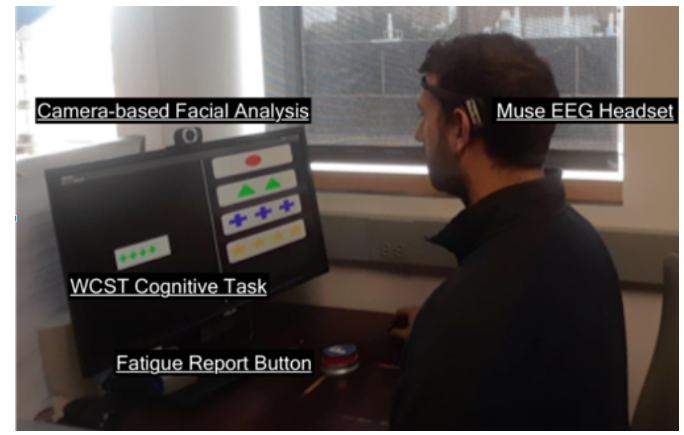
Figure 3. The Data Collection Experimental